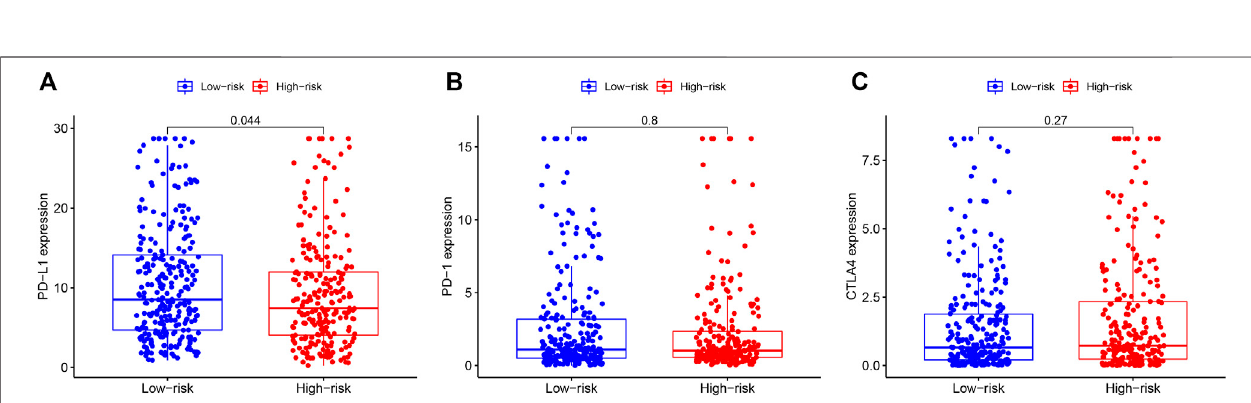
FIGURE 10 | Expression levels of ICGs in high- and low-RS groups (A) PD-L1 expression of THCA patients in high- and low-RS groups. (B) PD-1 expression of THCApatientsinhigh-andlow-RSgroups. (C) CTLA4expressionofTHCApatientsinhigh-andlow-RSgroups.RS,riskscore;PD-L1,programmedcelldeathligand1; THCA, thyroid carcinoma; PD-1, programmed death 1; CTLA4, cytotoxic T lymphocyte-associated protein